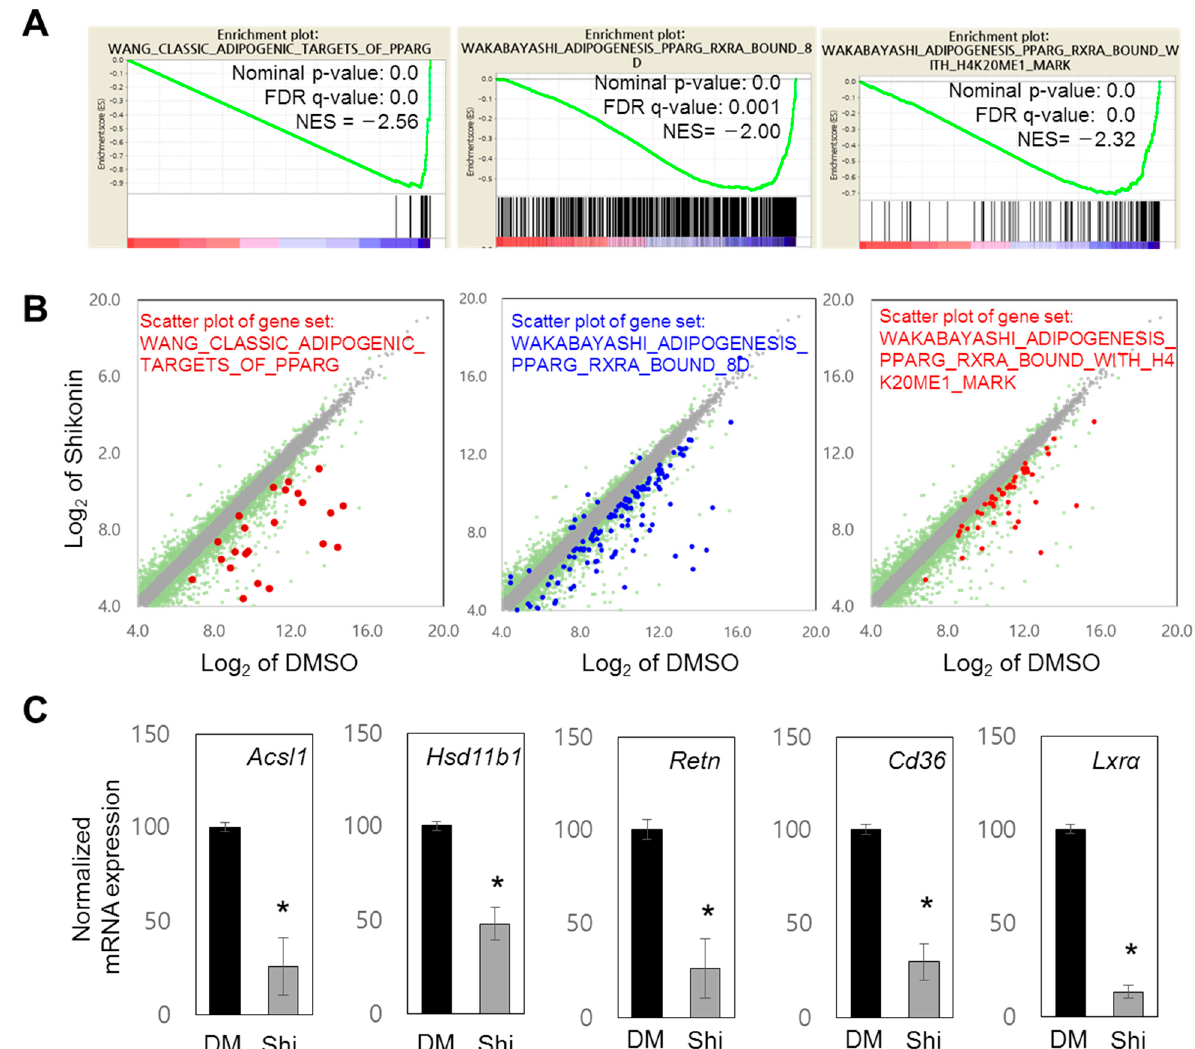
Figure 2. Genome-wide RNA-seq analysis of shikonin-regulated genes. ( A ) Gene sets significantly associated with PPAR γ were targeted through GSEA, and the normalized enrichment score (NES) was measured. Gene sets with a nominal p -value of <0.05 and false discovery rate (FDR) q -value of <0.25 were considered significantly enriched. ( B ) Scatter plot analysis of selected gene sets. In total, 13,965 signi fi cant genes (log2 value of mRNA expression > 4.0 in RNA-seq of DMSO or shikonin) are displayed in gray. Among them, 2406 genes with a 1.5-fold change in expression level are shown in green. The distribution of genes associated with the indicated GO terms are displayed by brown, blue, and red spots. ( C ) E ff ects of shikonin on the mRNA expression of fi ve PPAR γ response genes. 3T3-L1 cells were di ff erentiated and treated with DMSO or shikonin, then their transcript expres- sions were measured by RT-qPCR and normalized to GAPDH. Results are presented as the relative expression compared to DMSO controls. Values are represented as the means ± SDs from three in- dependent experiments (* p < 0.05). 3.3. Shikonin Acts as an Antagonist by Directly Binding PPAR γ Based on our results, we hypothesized that shikonin directly interacts with the lig- and-binding domain of PPAR γ and suppresses the transcriptional activity of PPAR γ . We explored the e ff ect of shikonin on PPAR γ activity. Luciferase reporter gene assays were carried out in HEK293 cells. Cells were co-transfected with a PPARE-tk-luciferase reporter and a PPAR γ -expressing plasmid in the presence of 1 µM rosiglitazone and increasing concentrations of shikonin. Shikonin inhibited the ligand-induced gene activation of PPAR γ in a dose-dependent manner (Figure 3A). Next, we measured the inhibitory e ff ects